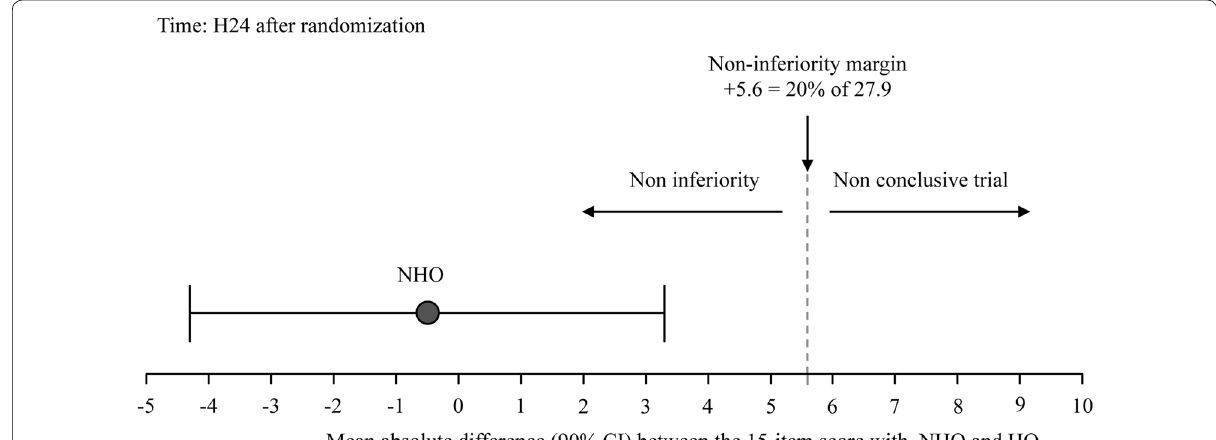
Fig. 3 Absolute difference (with confidence interval) between the 15-item comfort scores at H24 after randomization between humidified oxygen (HO) and non-humidified (NHO) oxygen. NHO was non-inferior compared to HO in terms of comfort at H24